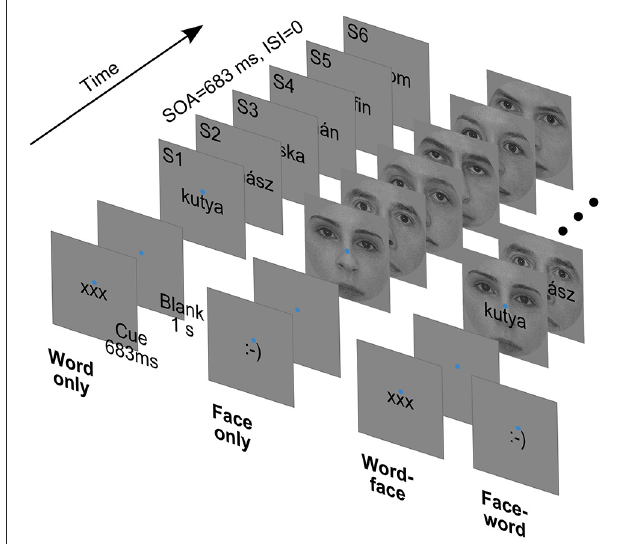
FIGURE 1 | Cues and sample stimulus trains from the four experimental conditions . SOA: Stimulus Onset Asynchrony. ISI: Interstimulus